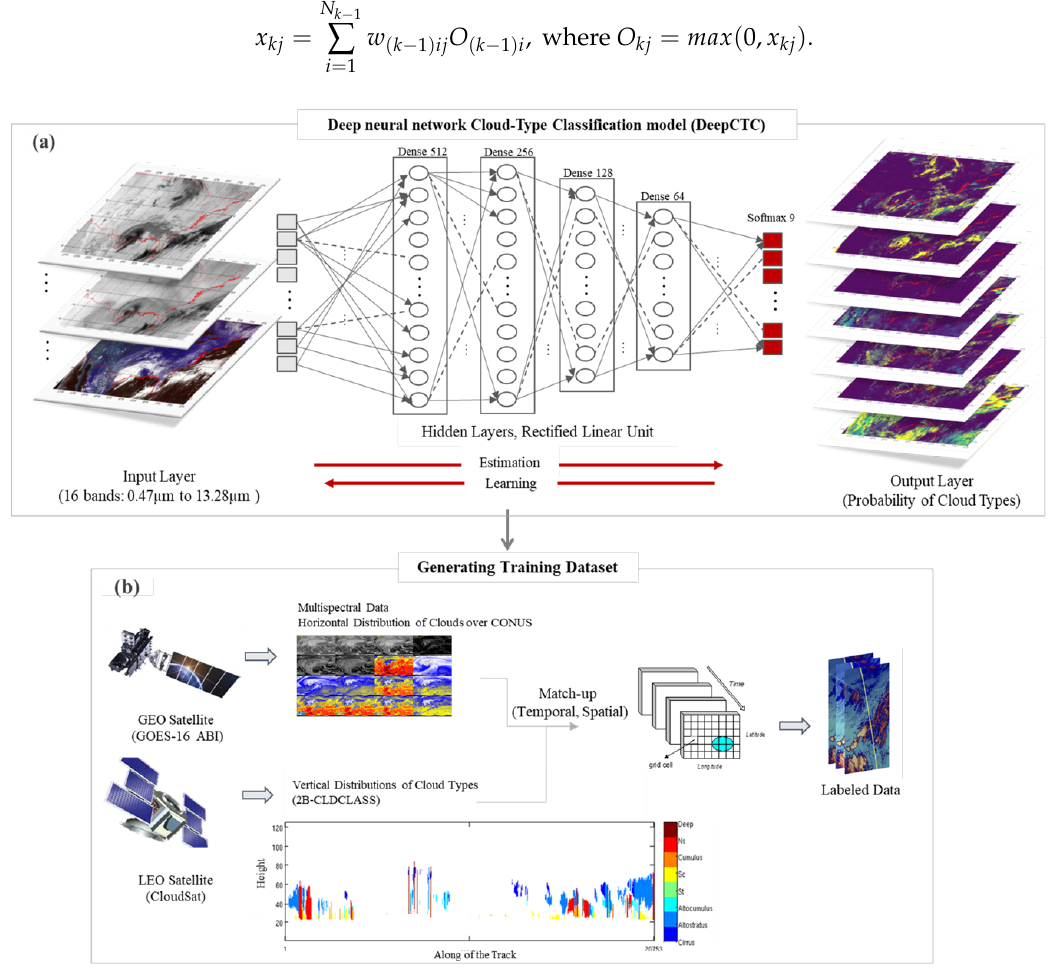
Figure 1. The workflow of DeepCTC. ( a ) Structure of deep neural network; ( b ) GEO- and LEO-based data integration to generate labeled